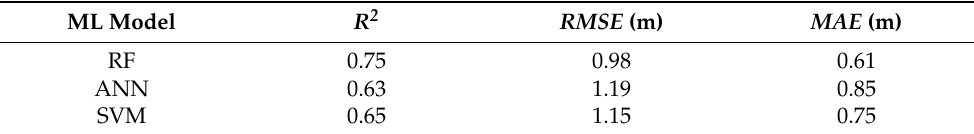
Table 2. Result scores obtained from the training of the three different models.